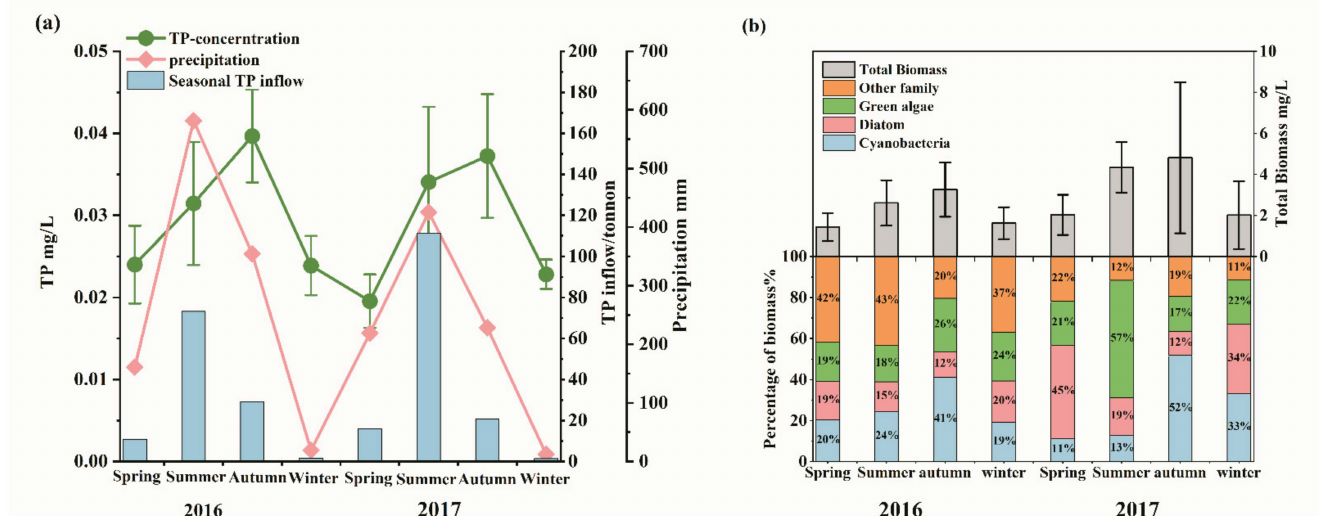
Figure 3. Seasonal variation of phosphorus concentration, phosphorus inflow and main algal groups in 2016–2017: ( a ) the seasonal average phosphorus concentration, total phosphorus load and precipi- tation; ( b ) the variation of total biomass and composition of algal